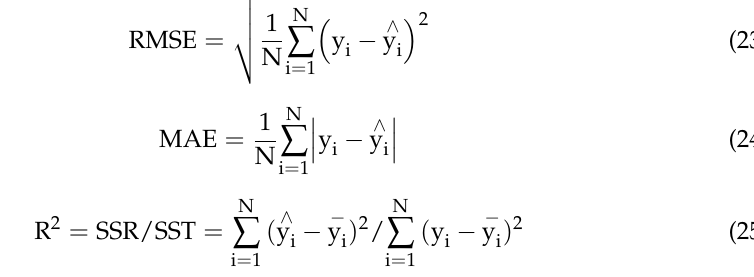
Figure 6. CEEMD decomposition results of month − by − month precipitation in Zhoukou City for 1978–2022. As can be seen in Figure 6, the frequencies and amplitudes of the IMF1 and IMF2 components are still at a high level but with less fl uctuation and more smoothing than the original data. The frequencies and amplitudes of IMF3–8 decrease gradually with the trend term, and the series gradually tends to be smoother. Table 1 shows the monthly precipitation series and its decomposition results for Zhoukou City. From the data in the table, the standard deviation of each component is smaller than the standard deviation of the original precipitation series, indicating that the components are less volatile and closer to the mean. In addition, the skewness and kurto- sis of the raw precipitation series are larger, indicating that the raw precipitation data are distributed asymmetrically and have more extreme values. In contrast, the skewness val- ues of IMF2, 3, 4, 6, and 8 are close to 0, indicating that their distributions are